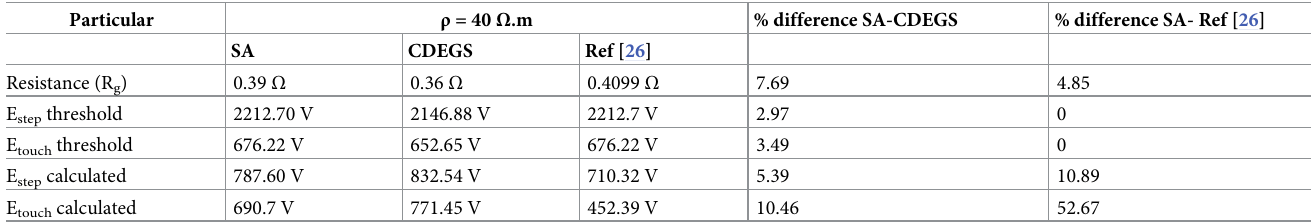
Table 8. Results for grounding system in uniform soil.